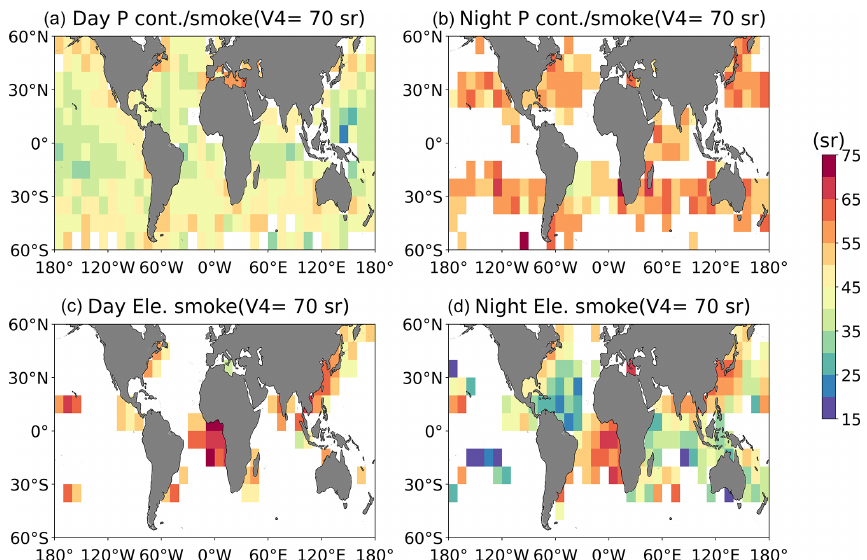
Figure 16. Lidar ratios as in Fig. 11 but for polluted continental/smoke (a, b) and elevated smoke (c, d) , classified from 5 and/or 20km spatially averaged data. Values are reported for grids constructed with at least 20